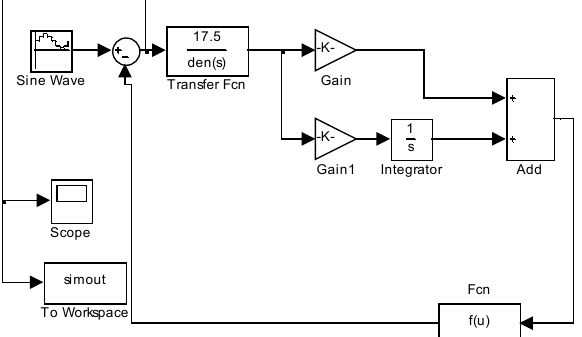
Figure 5. Simulation of the tracking error with subdivision errors.